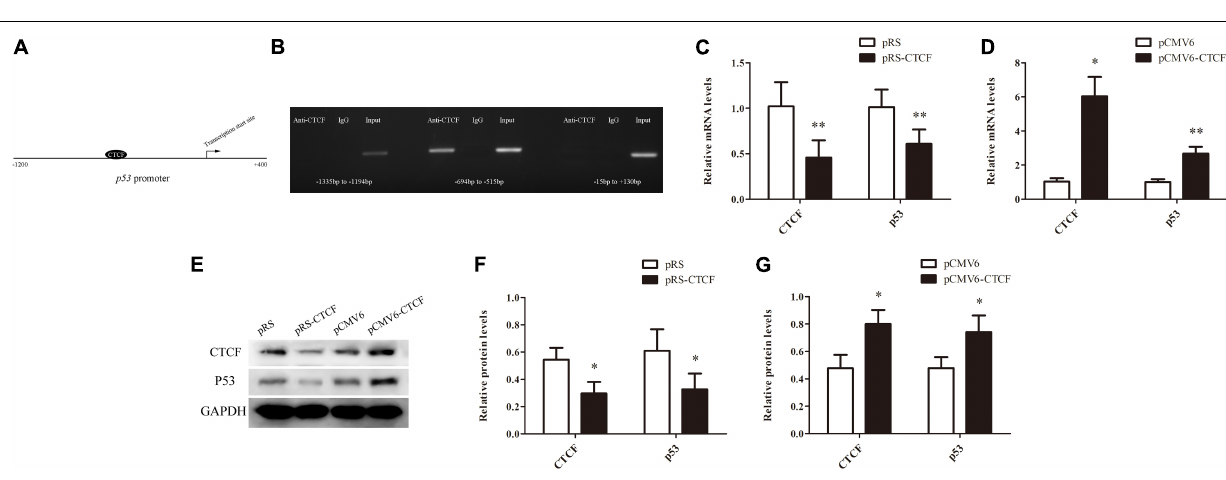
or interference plasmid by ChIP-qPCR. The results showed increased histone H3K9ac and H3K14ac levels in the p53 promoter region after ectopic expression of CTCF in normal CD4 + T cells ( Figure 5A ). Conversely, H3K9ac and H3K14ac